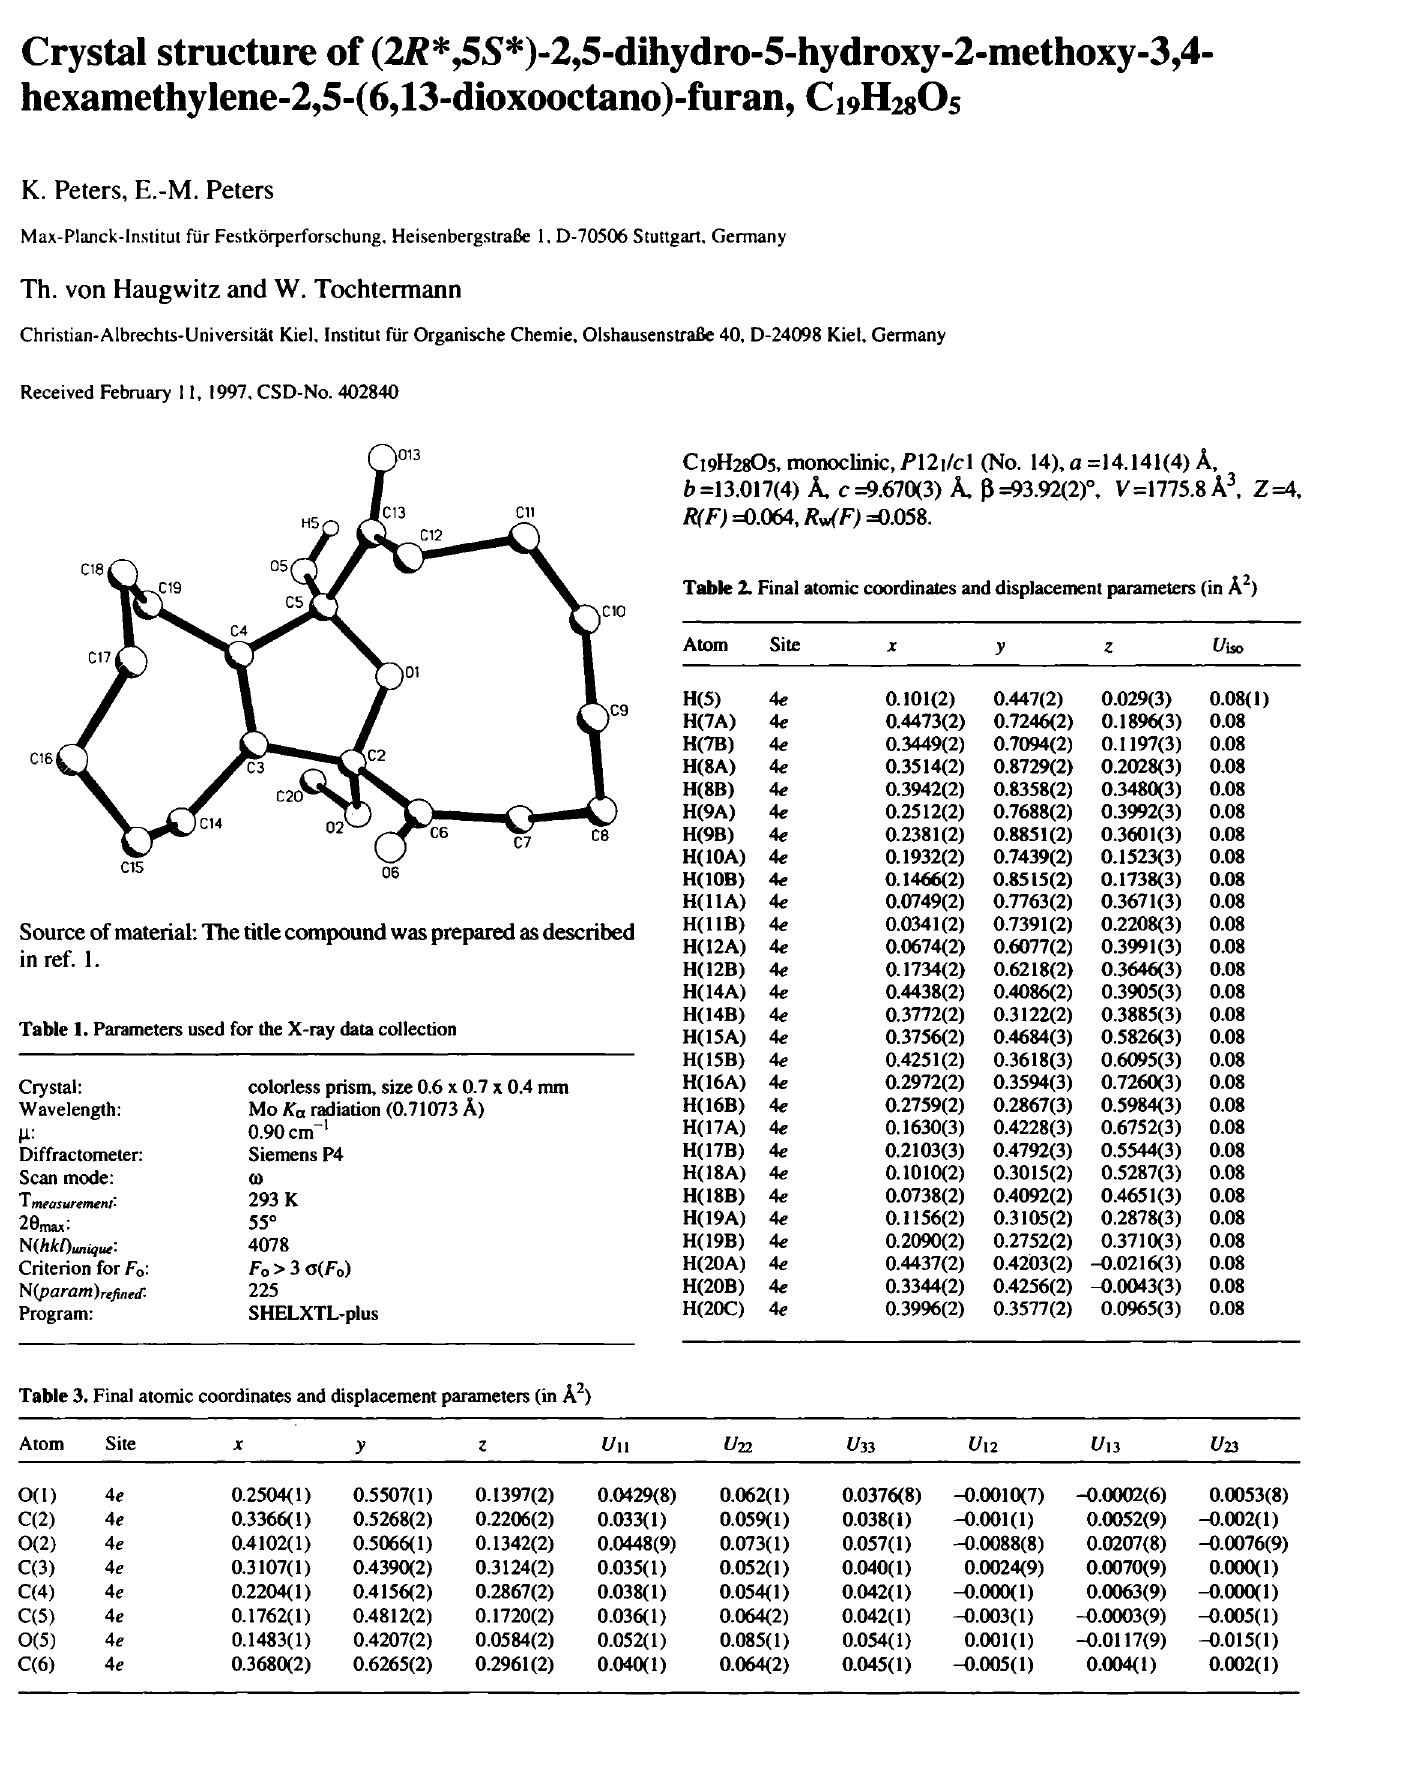
Table 3. Final atomic coordinates and displacement parameters (in Â^)